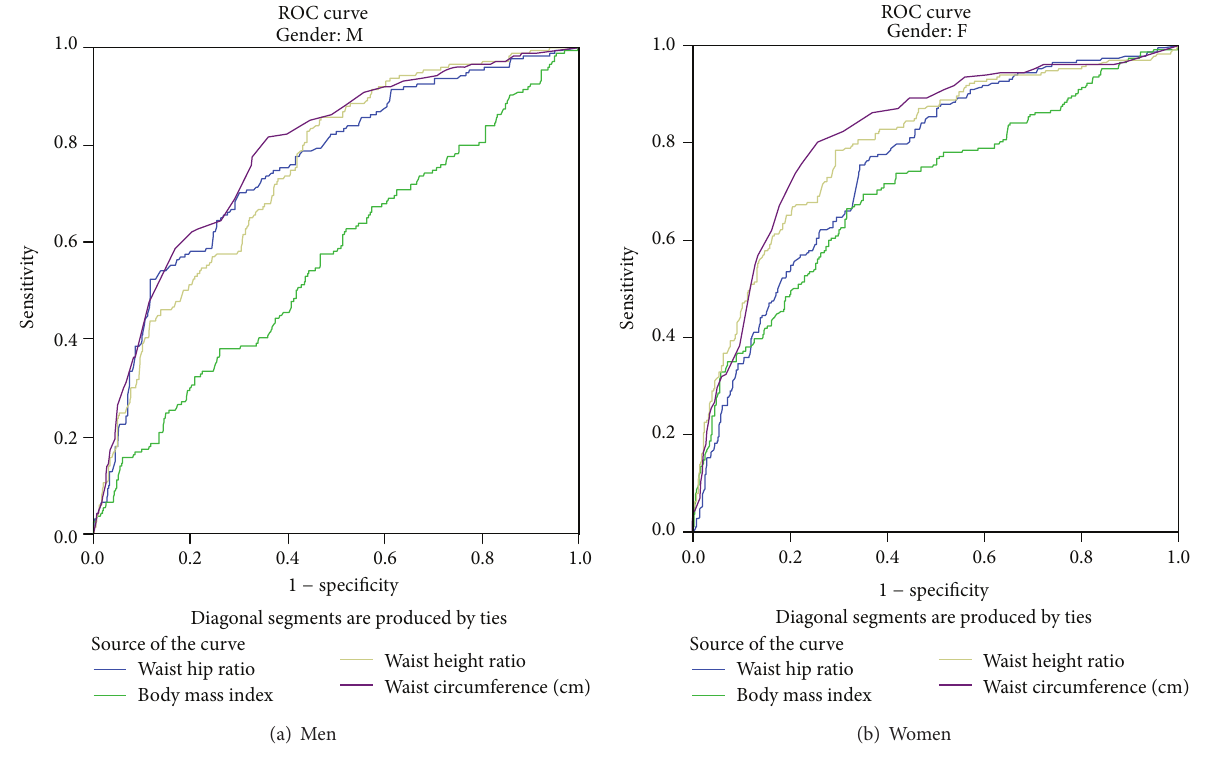
Figure 1: Receiver operating characteristics curve